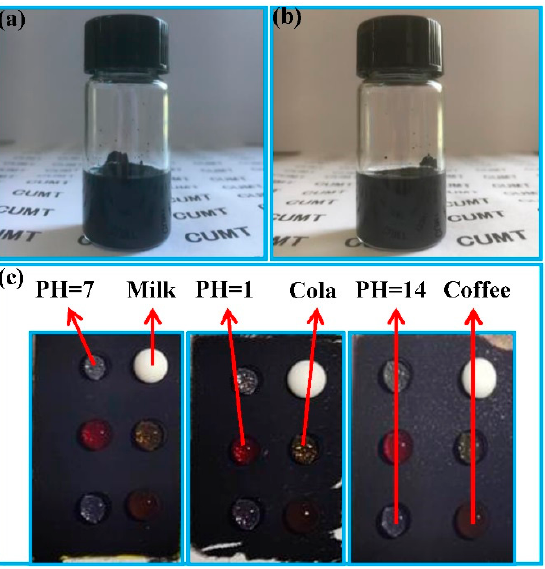
Figure 2. ( a ) Digital picture of the fabricated paint; ( b ) digital photo of the paint after two weeks of storage; ( c ) the states of different droplets on the coating surface prepared on different substrates (from left to right, the three substrates are a polyimide (PI) film, a slide and Q345).